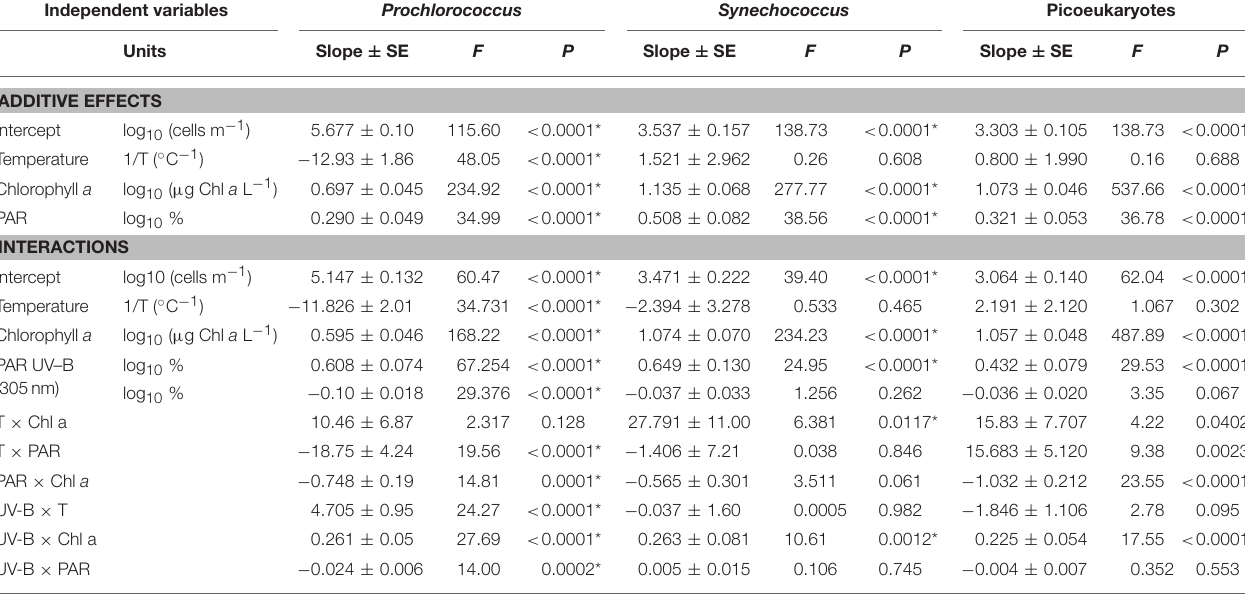
TABLE 3 | Additive effects and Interactions between autotrophic picoplankton abundance, temperature, chlorophyll a , PAR, and UVB radiation. Independent variables Prochlorococcus Synechococcus